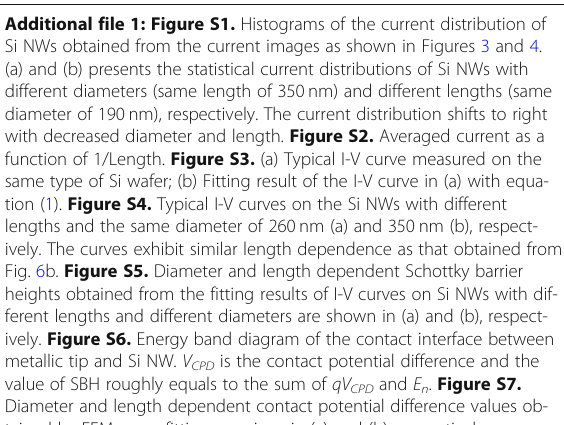
ively. Figure S6. Energy band diagram of the contact interface between metallic tip and Si NW. V CPD is the contact potential difference and the value of SBH roughly equals to the sum of qV CPD and E n . Figure S7. Diameter and length dependent contact potential difference values ob- tained by EFM curve fitting are given in (a) and (b),